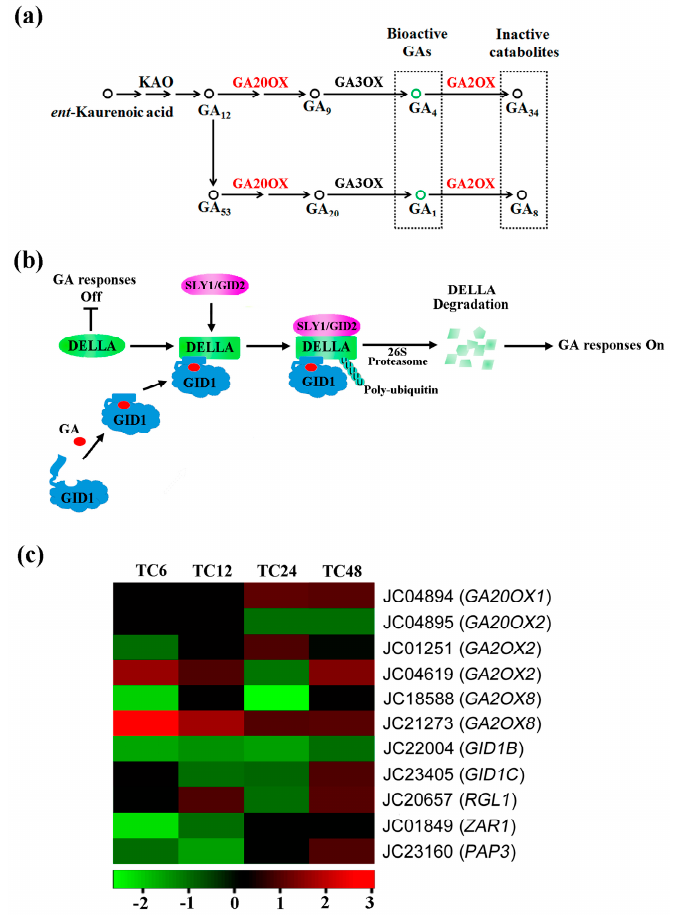
Figure 6. The DEGs analysis associated with gibberellin biosynthetic and signaling pathways after GA 3 treatment in J. curcas . ( a ) Gibberellin biosynthetic pathway, KAO: ent -kaurenoic acid oxidase, GA20OX: GA 20-oxidase, GA2OX: GA 2-oxidase, GA3OX: GA 3-oxidase; ( b ) Gibberellin-signaling transduction pathway, T bar is the inhibition; ( c ) The heat-map of DEGs associated with GA biosynthesis and signaling pathways after GA 3